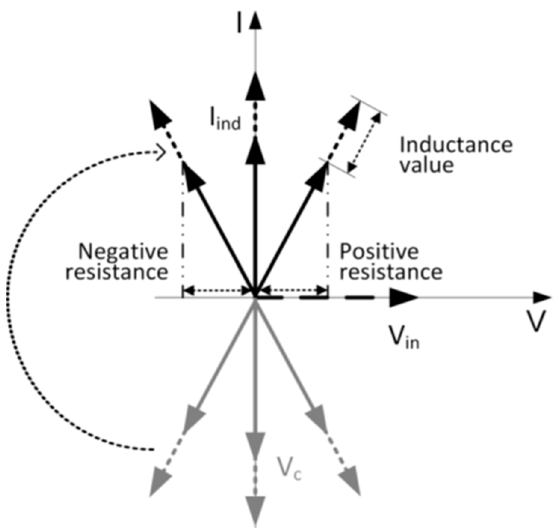
Figure 3. Phasors of voltages and currents in the AI of Figure 2 in the complex phasor plane. Vin is the input voltage, V C the current across the capacitor (Figure 2a) or at the output of the phase shifting network (Figure 2b), and I ind the current drawn from the inverting transconductance amplifier.3. Low-current design of GaAs active filters based on the proposed AI.